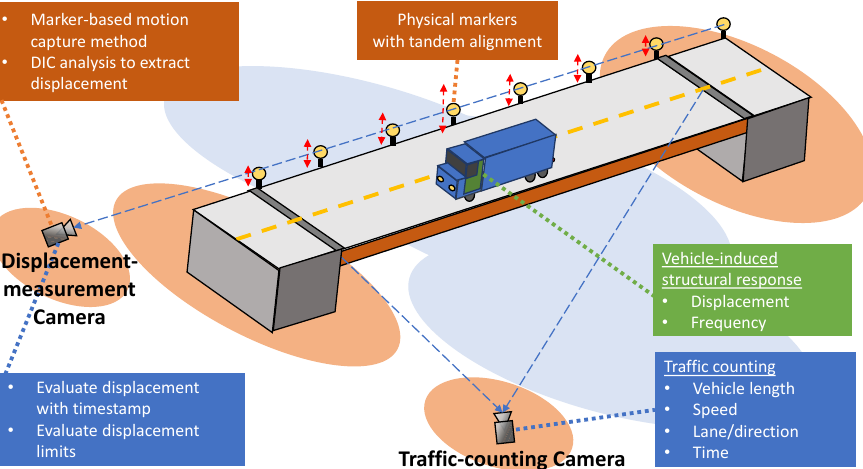
Figure 1. Framework of the SHM method for traffic-induced dynamic displacement measurement using marker-based motion capture and traffic counting cameras. The method incorporates a frontal-positioned camera to measure displacement from multiple points simultaneously and a side-positioned traffic counting camera that allows more-accurate capturing of passing vehicles. DIC and traffic counting algorithms are concurrently implemented to measure the displacement and frequency response of the traffic-induced